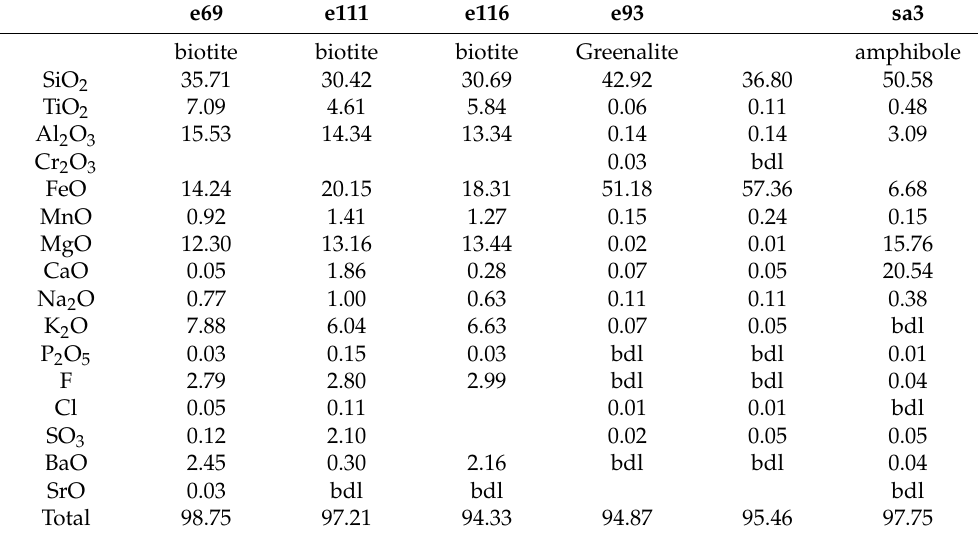
Table 3. Representative biotite and greenalite analyses.